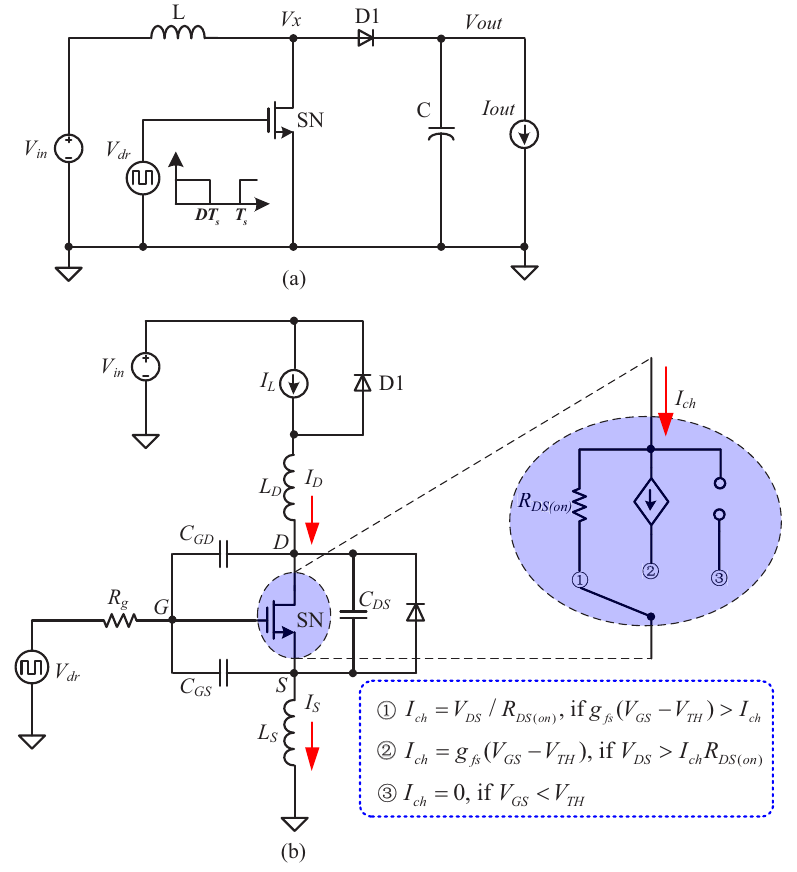
Figure 1. ( a ) Boost converter with practical realization using a MOSFET and diode; ( b ) MOSFET switch with a partially clamped current load (three states of the MOSFET: 1 (cid:13) → ON, 2 (cid:13) → ACTIVE, 3 (cid:13) →